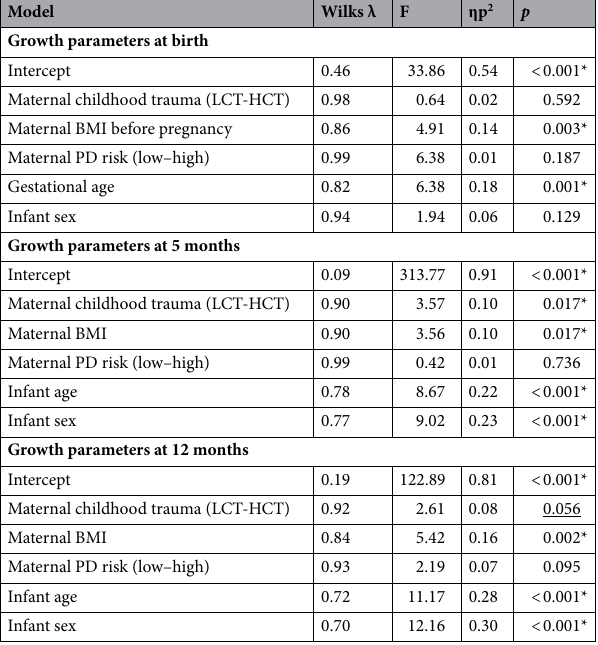
Table 2. Results of MANCOVA models for the association between level of maternal childhood trauma (LCT, HCT), maternal BMI, maternal postnatal depression risk infant age, sex, and child growth parameters at birth, at 5, and 12 months. Significant effects asterisked and marginally significant